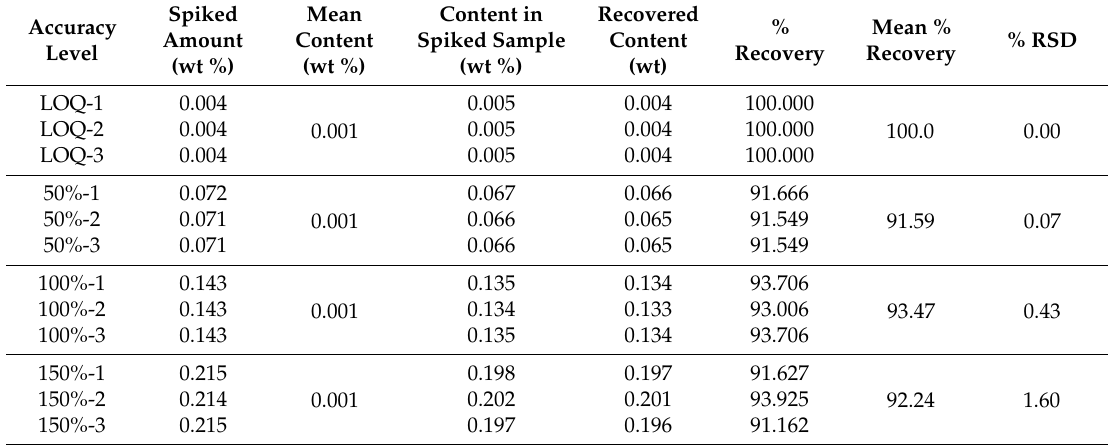
Table 6. Accuracy of S -enantiomer detection in rasagiline tartrate at various concentration levels.